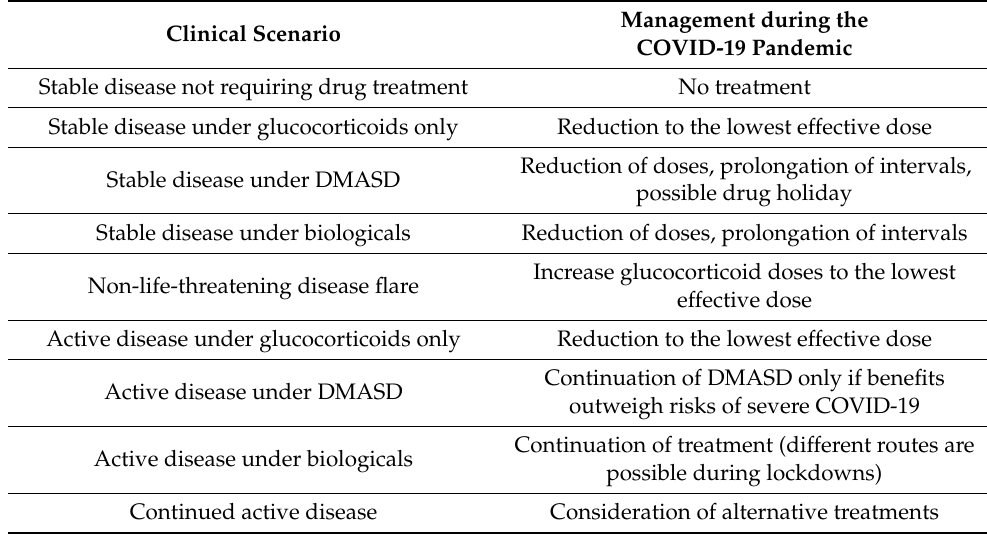
Table 2. Overview of expert recommendations on the optimal management of sarcoidosis treatment during the COVID-19